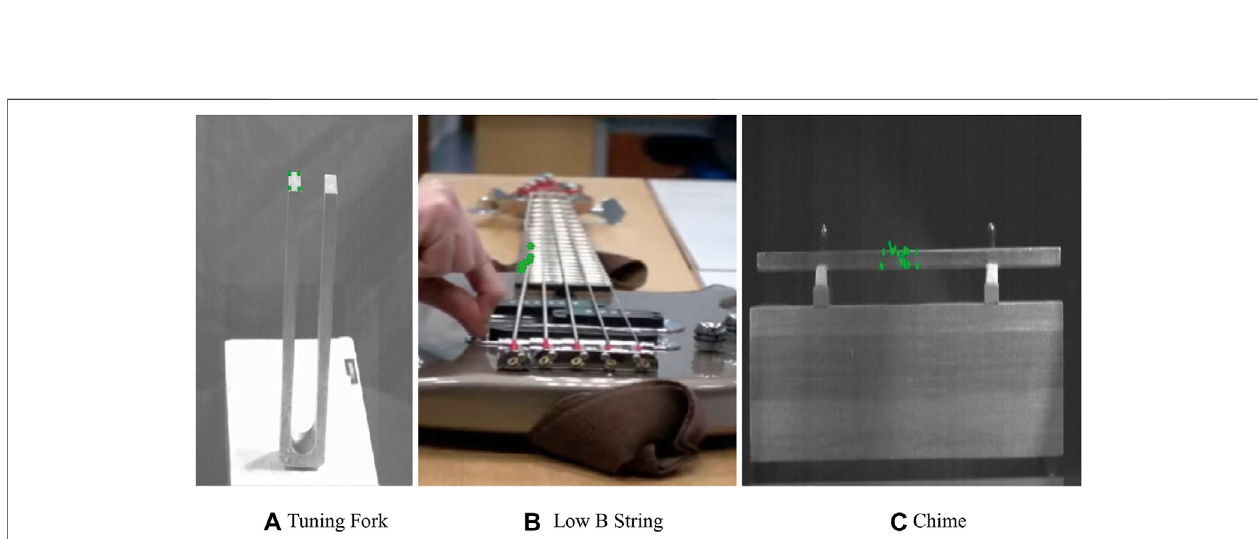
FIGURE 13 | Three real videos. (A) Tuning Fork (B) Low B String (C) Chime.